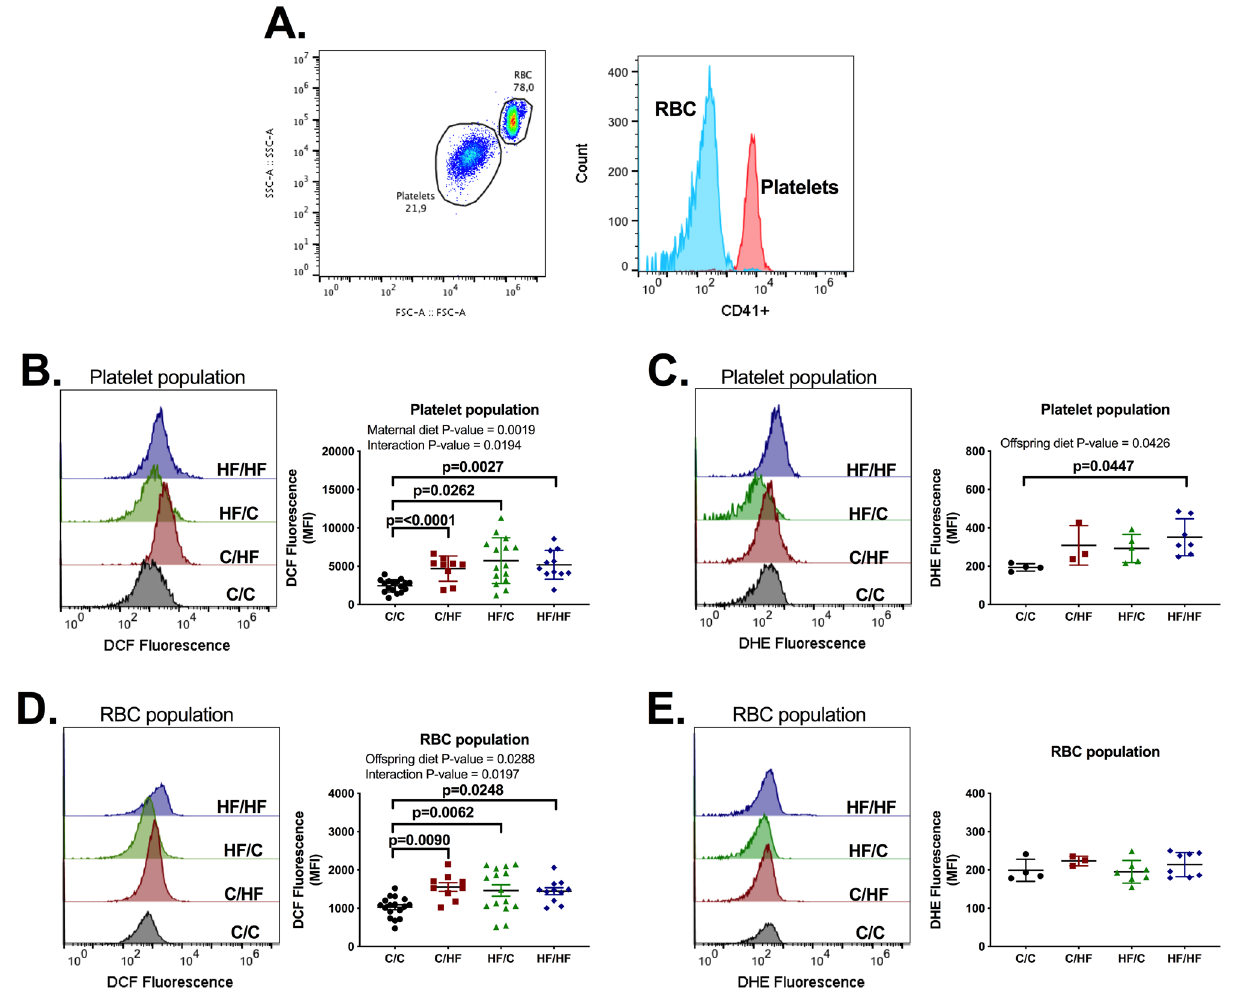
Figure 5. Maternal or offspring high-fat diet induced increased oxidative stress in whole blood of male offspring. Whole blood was diluted 25 times with Tyrodes-HEPES buffer and platelets population labelled with CD41 + antibody for 30 min ( A ). Whole blood was incubated with 20 µM DCFDA or 10 µM DHE and fluorescence determined for platelet ( B , C ) and RBC ( D , E ) populations using a flow cytometer. C/C, dam and offspring fed standard laboratory diet; C/HF dam fed standard laboratory diet and offspring fed high-fat diet; HF/C dam fed high-fat diet and offspring fed standard laboratory diet; HF/HF dam and offspring fed high-fat diet. For ( B ) and ( D ), n = 10–17 mice from 7–9 litters per group. For ( C ) and ( E ), n = 4 animals from 3 litters for C/C, n = 3 animals from 3 litters for C/HF, n = 5 animals from 4 litters for HF/C and n = 7 animals from 4 litters for HF/HF. Graphs show mean ± SEM as well as individual values. Data analysed by two-way ANOVA with Tukey’s multiple comparisons test. The overall effects of maternal and offspring diet are reported where